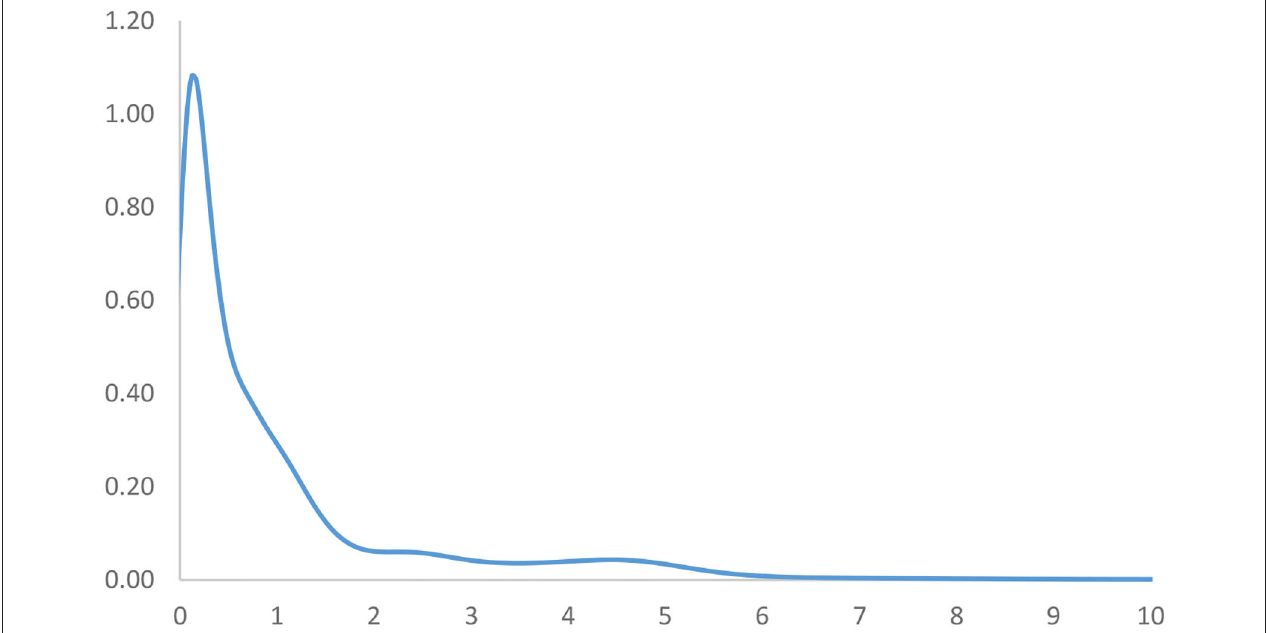
FIGURE 3 | Ergodic distribution for the relative RIVAPC of all countries with annual transitions. Source: authors’ calculation. N.B. The vertical axis indicates the density of probability and the horizontal axis indicates RIVAPC values.